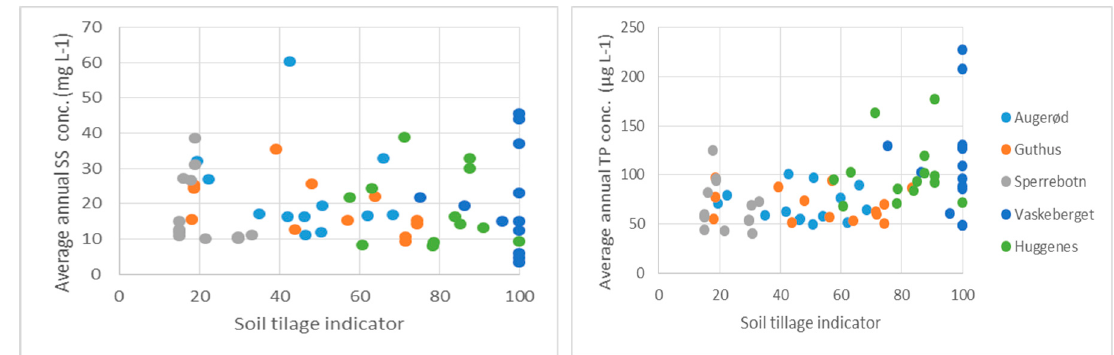
Figure 8. Effects of soil tillage in autumn (soil tillage indicator: 100 equals all agricultural area autumn ploughed) on average annual suspended sediment (SS) and total phosphorus (TP) concentrations.